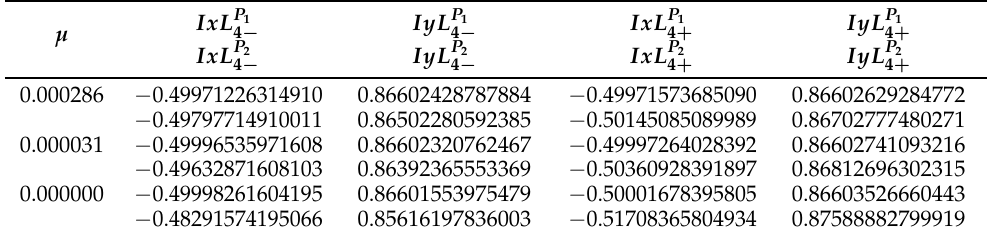
Table 12. Inline equilibrium solution near L 4 of different planetary systems.